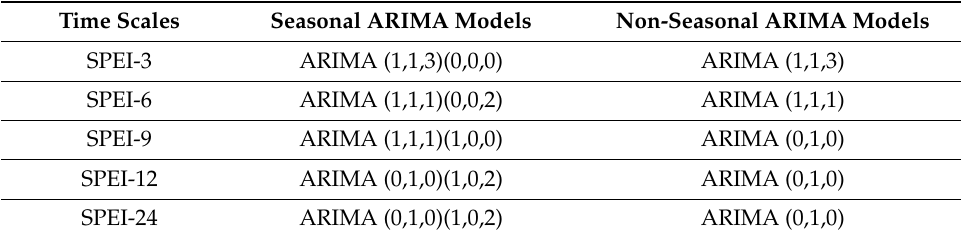
Table 6. Seasonal ARIMA and non-seasonal ARIMA models.